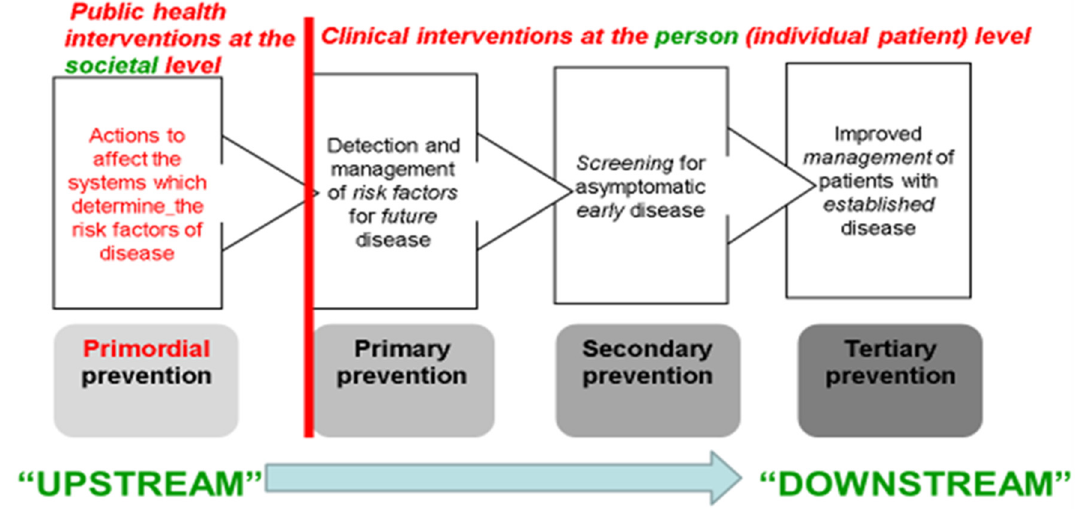
Figure 2. Four Types of Prevention Spanning Rose’s Two Strategies [7] .